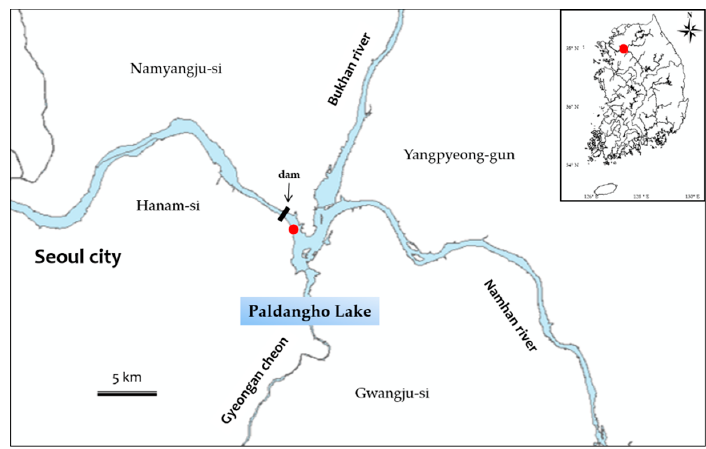
Figure 1. A map of the reservoir with the test site (red dot). Paldangho Lake was a dam that collects